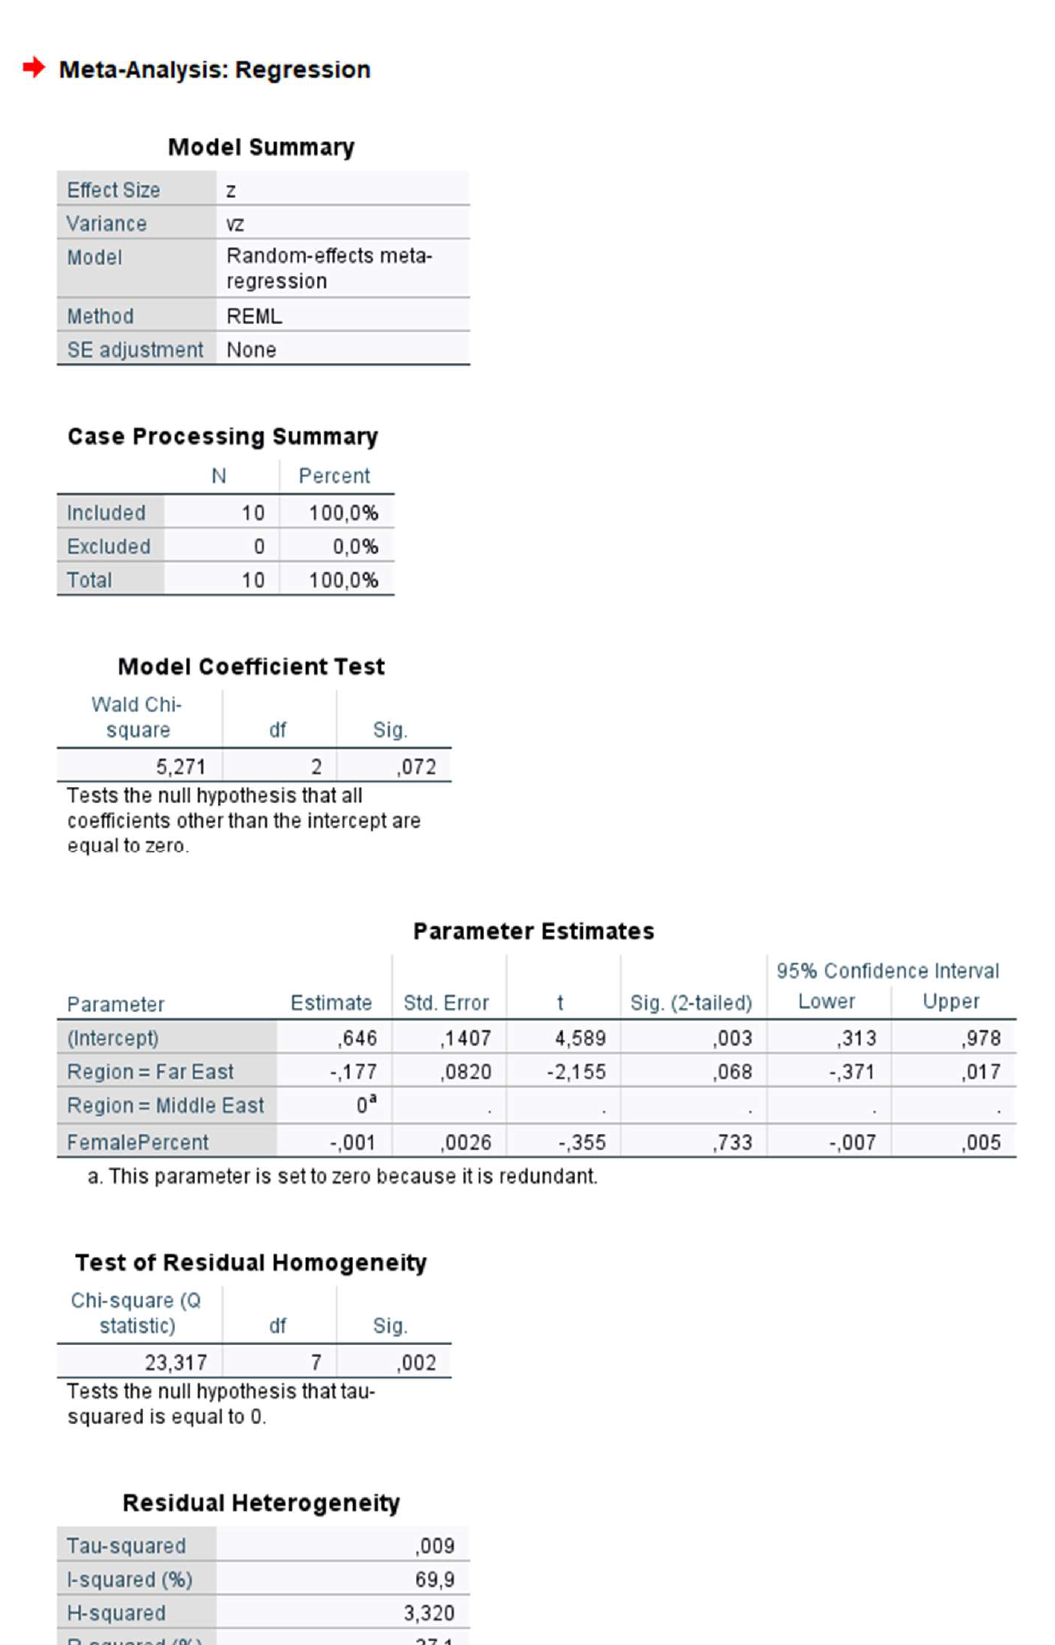
Figure 20. Results of Meta-regression Analysis with Female Percentage.